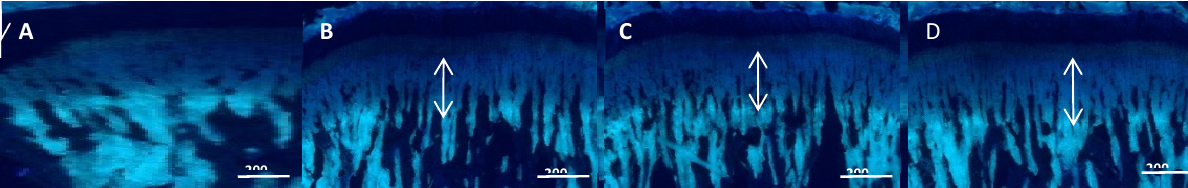
Figure 6. Representative fluorescence photographs of the proximal tibial growth plate in rats. Arrows imply the distance of bone growth in proximal tibia for 72 h period, ( A ) Control, ( B ) rhGH 200 µg/kg (s.c.), ( C ) HT042 100 mg/kg (p.o.), ( D ) HT042 300 mg/kg (p.o.). Scale bar; 200 µm.